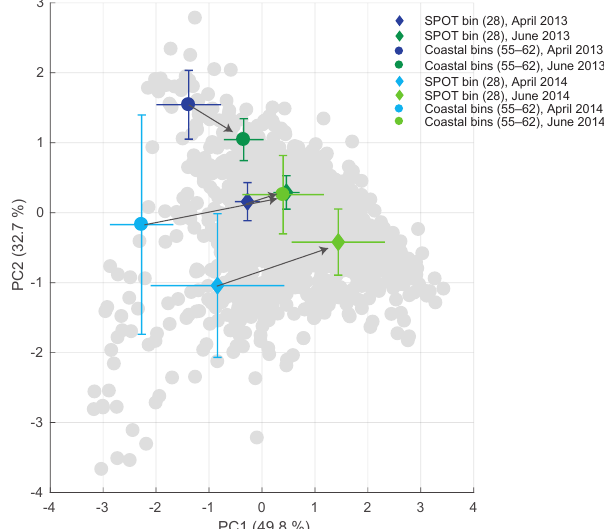
Figure 6. Seasonal progression of bins along the transect. Two ex- amples are shown: SPOT (bin 28) and nearshore bins (average for bins 55–62). The average and standard deviation for April (blues) and June (greens) are shown. Both sites show a transition from low PC1 values to elevated PC1 values, indicating increased offshore